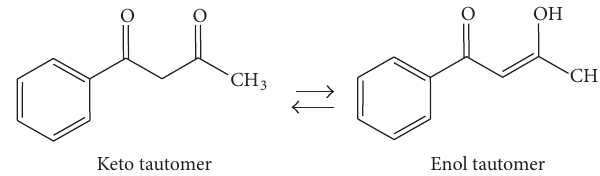
Figure 1: Keto-enol tautomerism of benzoylacetone ( 𝛽 -diketone).